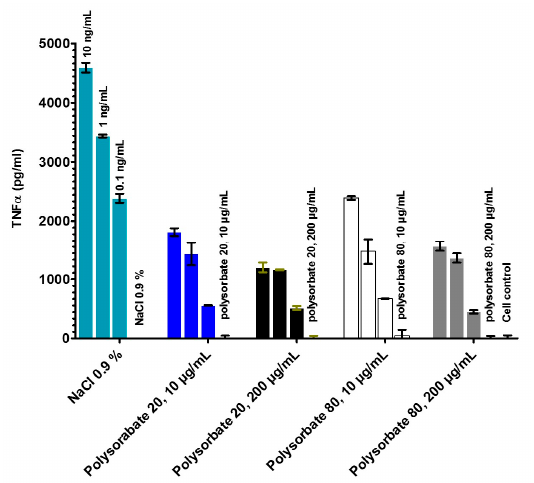
Figure 3. Secretion of tumor-necrosis-factor α (TNF- α ) by human mononuclear cells induced by LPS from E. coli O55:B5. LPS aggregates were prepared in NaCl 0.9% and polysorbate 20 and 80. Three LPS concentrations 10, 1 and 0.1 ng/mL were tested. The error bar comes from two-fold determination of TNF- α concentration in the ELISA.